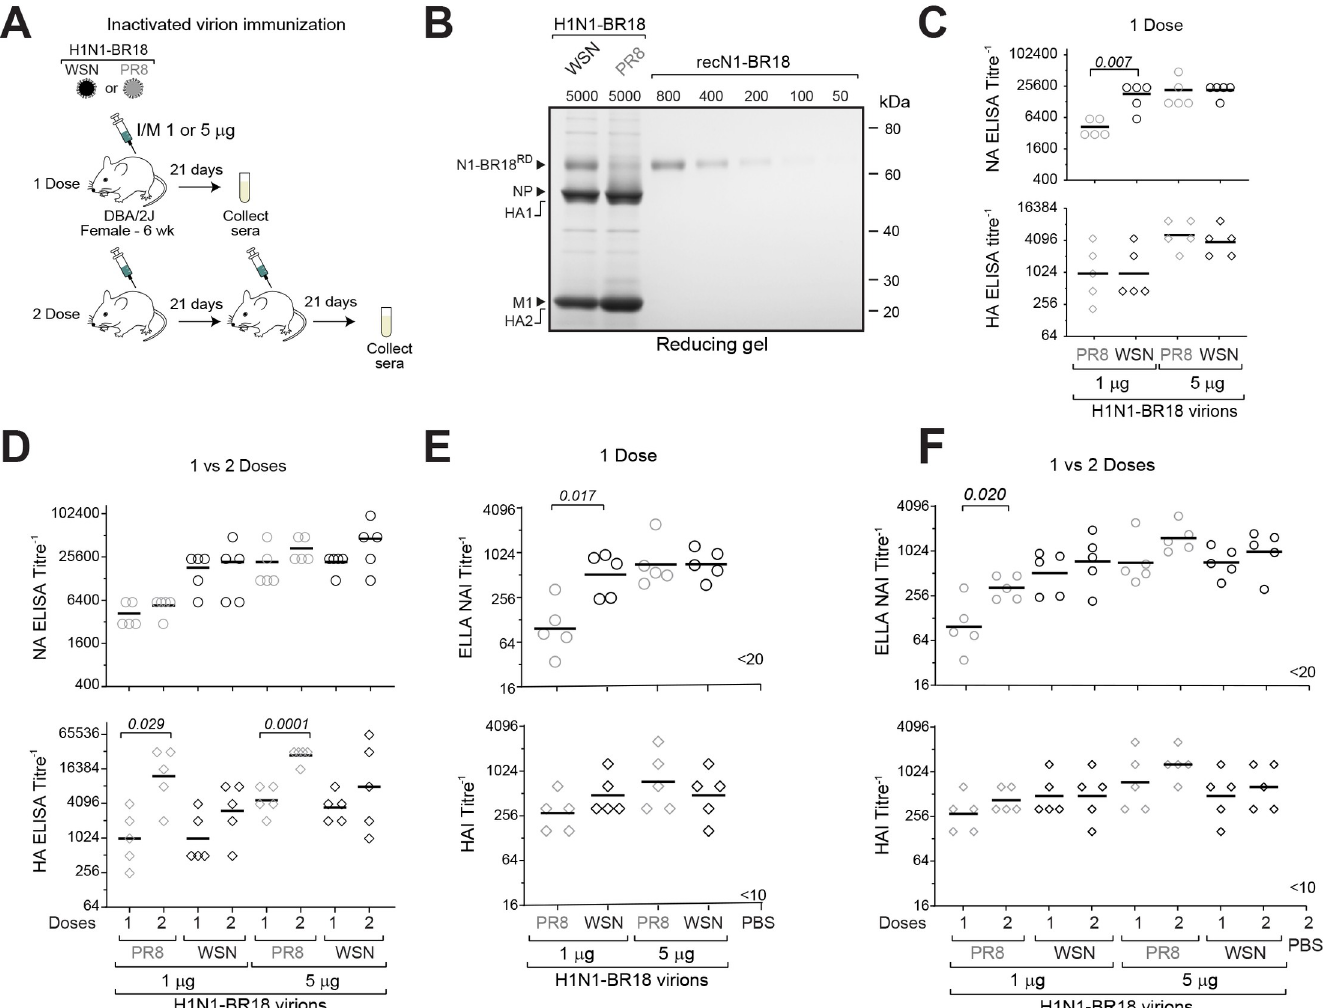
Fig 6. Higher NA virion content corresponds with a stronger NA antibody response. A. Diagram depicting the one and two dose immunization schemes in mice using two different amounts (1 μ g and 5 μ g) of the purified BPL inactivated WSN H1N1-BR18 and PR8 H1N1-BR18 virions. B. Reducing Coomassie stained gel used to estimate the NA content in the purified BPL inactivated virions by densitometry. Recombinant N1-BR18 was used as a reference standard. C. Serum NA (Top) and HA ELISA titres (Bottom) obtained from mice following 1 dose of the indicated virion amounts are displayed. P values comparing the different virions at each dose were calculated by a two-tailed unpaired t-test (95% CI). D. Graphs showing the serum NA (Top) and HA ELISA titres (Bottom) obtained from mice following one or two doses of the indicated virion amounts. P values comparing one and two doses for each virion and protein amount were calculated by a two-tailed unpaired t-test (95% CI). E. ELLA NAI titres (Top) and the HAI titres (Bottom) obtained from mice following one dose with the indicated virion amounts are displayed. P values comparing the different virions at each dose were calculated by a two-tailed unpaired t-test (95% CI). F. Graphs comparing the ELLA NAI titres (Top) and HAI titres (Bottom) in the mice that received one and two doses of the indicated virion amounts. P values comparing one and two doses for each virion and protein amount were calculated by a two-tailed unpaired t-test (95% CI).